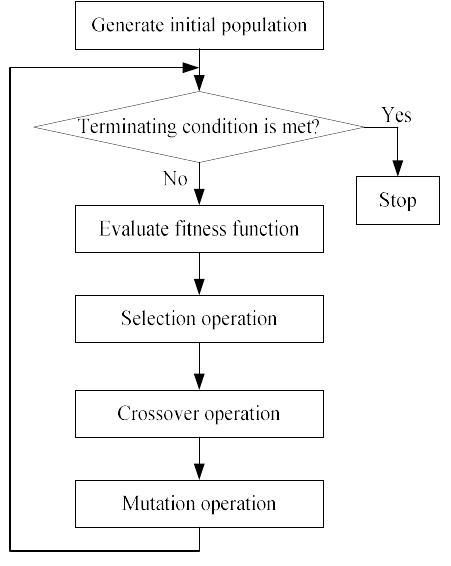
Figure 4. Genetic algorithm (GA).